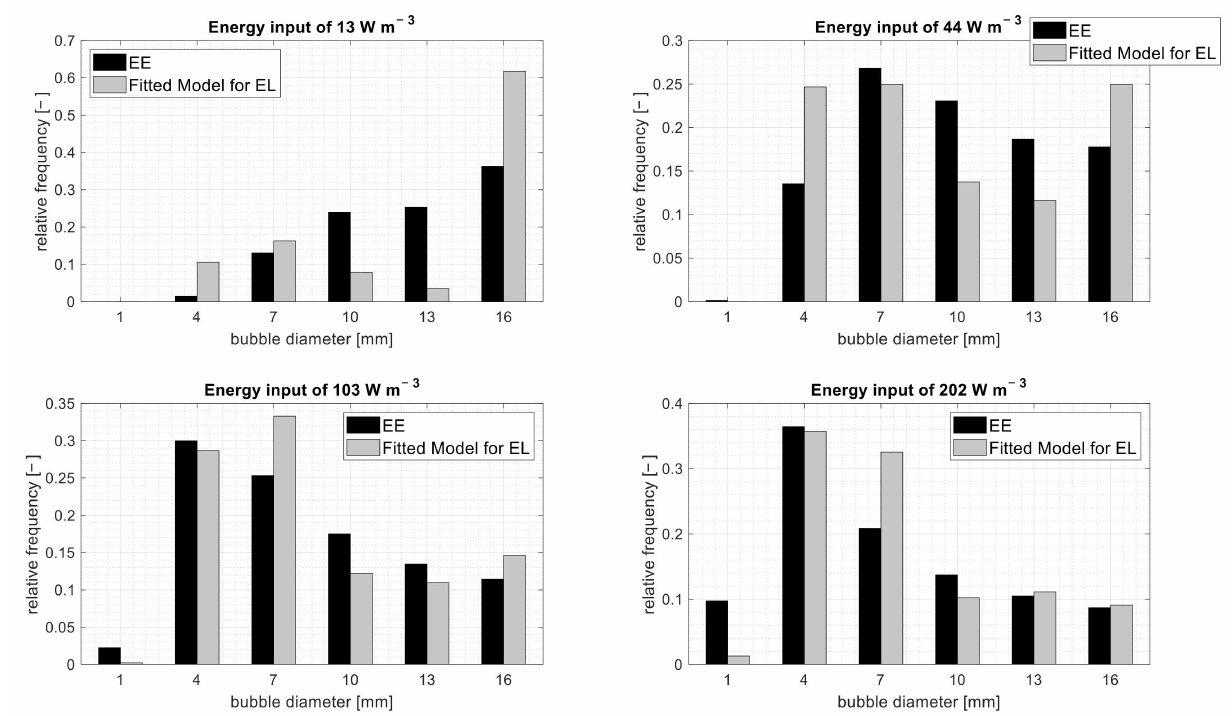
Figure 12. Comparison of the resulting bubble size distribution created with the Lehr et al. [1] model in the EE approach (black) and the fitted model for EL (gray). Shown for energy input of 13, 44, 103 and 202 W m − 3